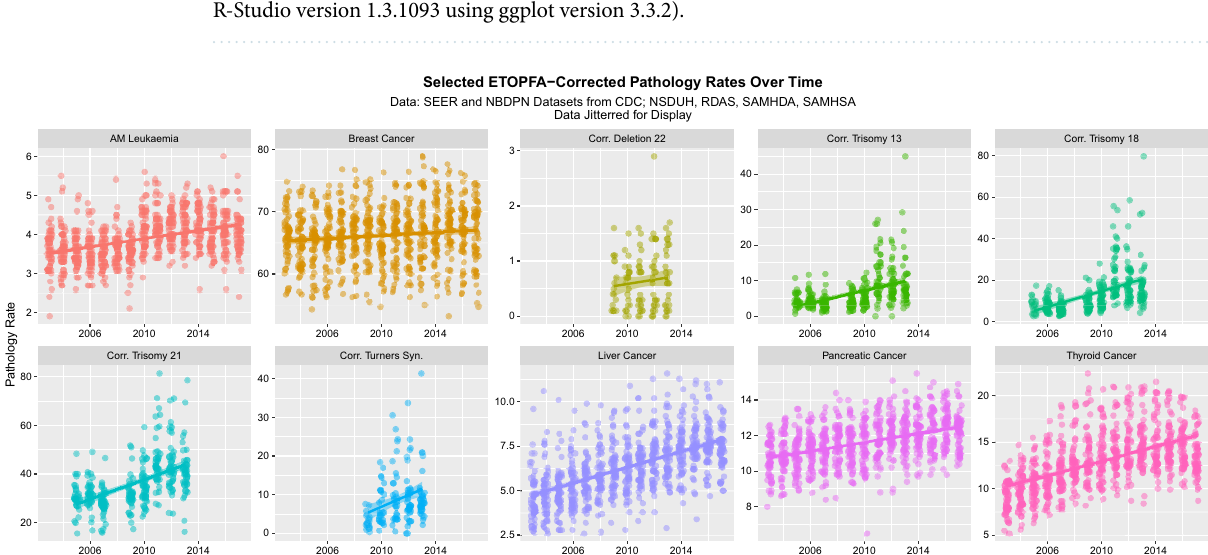
Corr. Trisomy 21 Corr. Turners Syn.